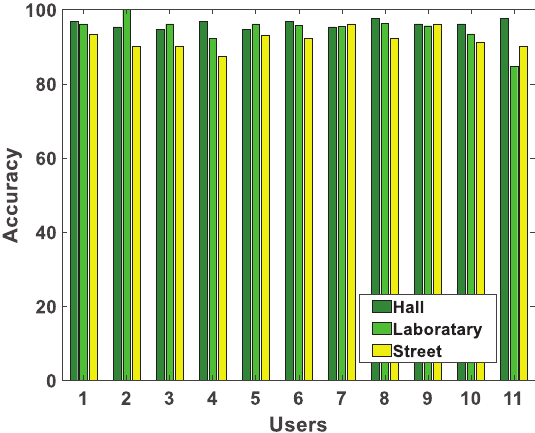
Figure 11. Accuracy at different